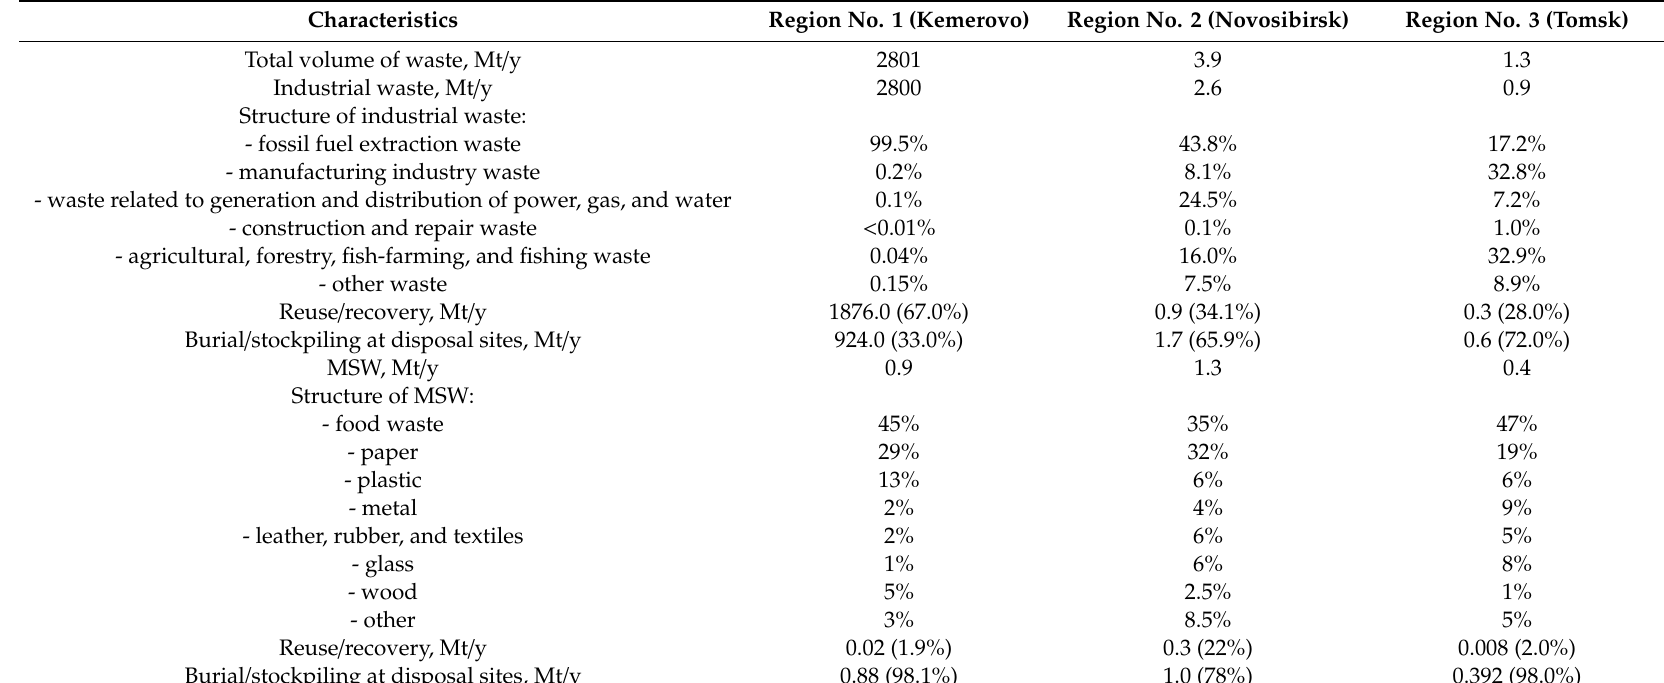
Table 7. Characteristics of waste in each of three regions [16].